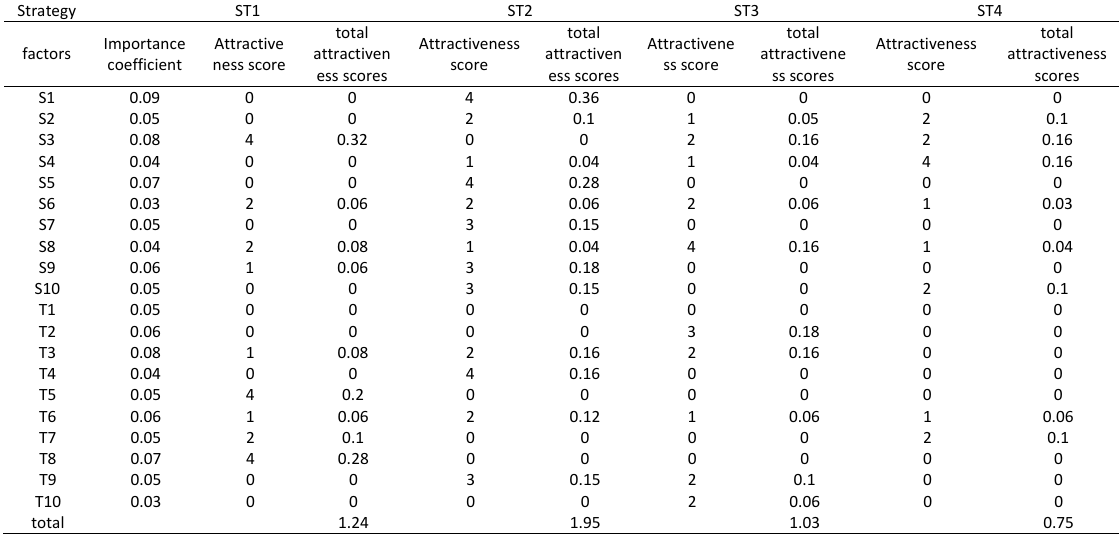
Table6: QSPM of WO strategies Table 7. QSPM of WO